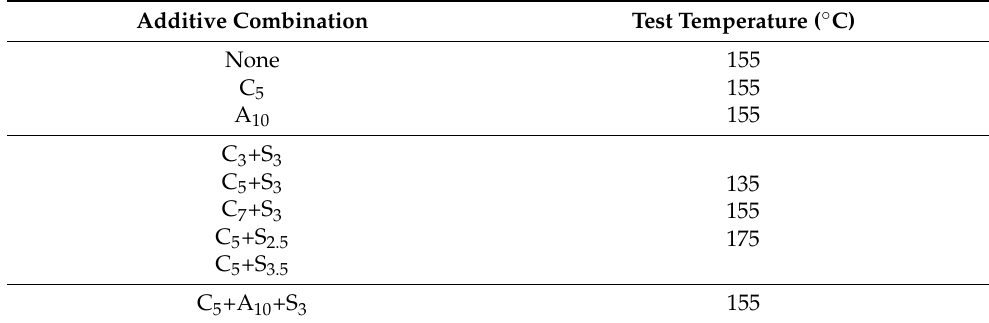
Table 2. Different additive combinations.